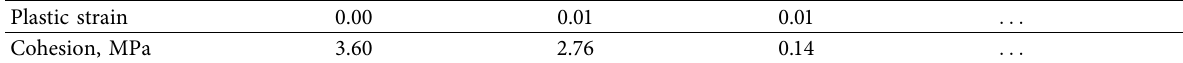
Table 2: Attenuation rules of the cohesion parameter for the coal material.